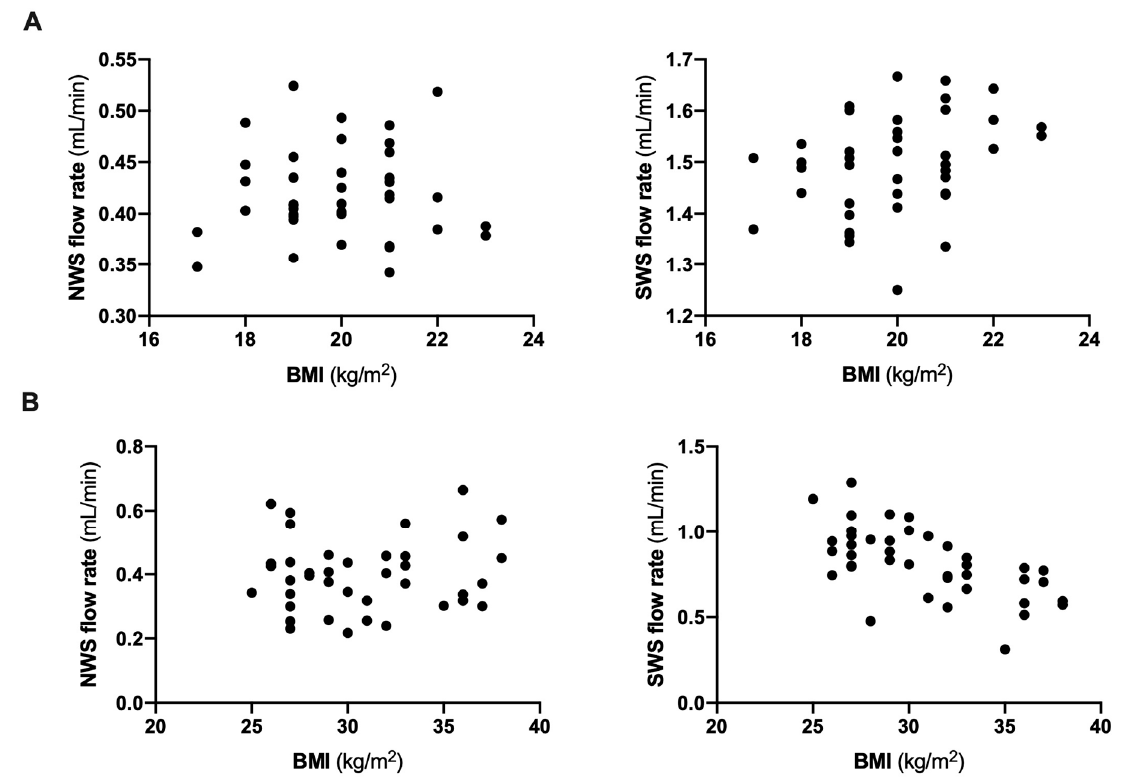
Figure 1. Scatter plots for BMI and non-stimulated and stimulated salivary flow rate in healthy children